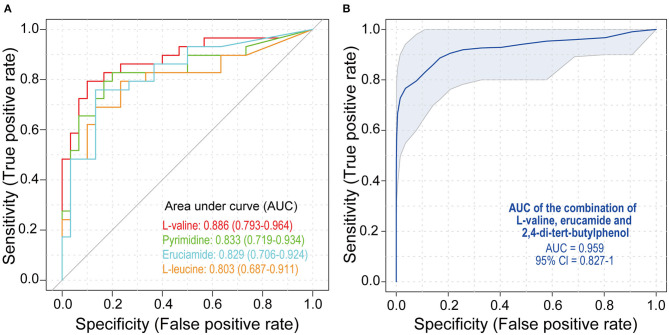
Receiver operating characteristic (ROC) analysis of metabolites. (A) ROC curves of L-valine, pyrimidine, erucamide, and L-leucine. (B) ROC curves of the combination of L-valine, erucamide, and 2,4-di-tert-butylphenol. SLE, systemic lupus erythematosus; HCs, healthy controls; ROC, receiver operating characteristic.